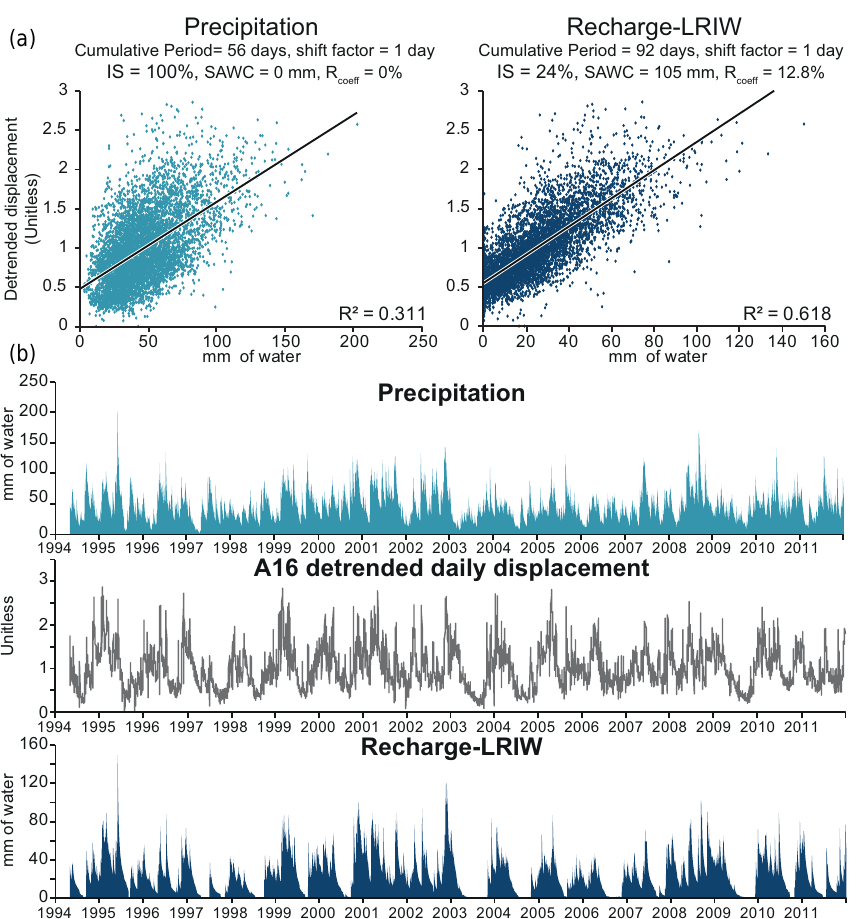
Figure 9. Best linear correlations for precipitation and recharge computed with the LRIW method. IS is for infiltration structures. SAWC is soil available water capacity. Cumulative period ( n ) and shift factor ( β) are the terms of Eq. (3). (a) Linear regression between precipitation/ R LRIW and A16 detrended displacement. (b) Correlation between precipitation/ R LRIW and A16 detrended displacement as a function of